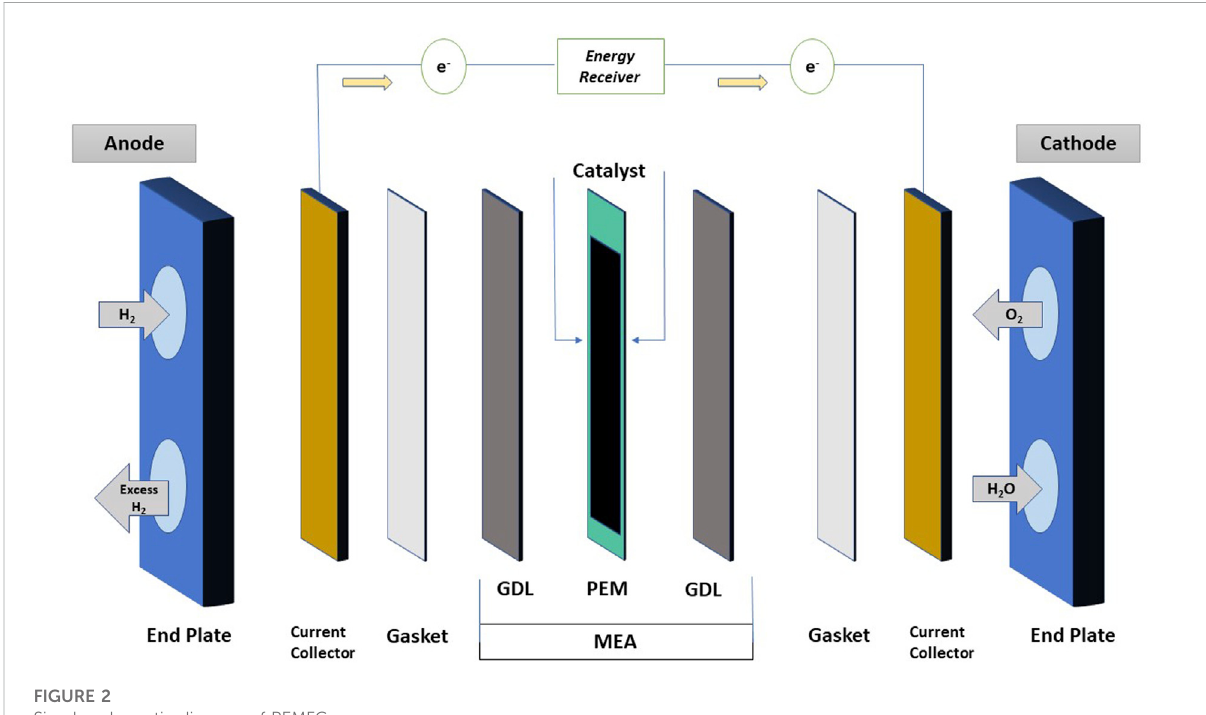
FIGURE 2 Simple schematic diagram of